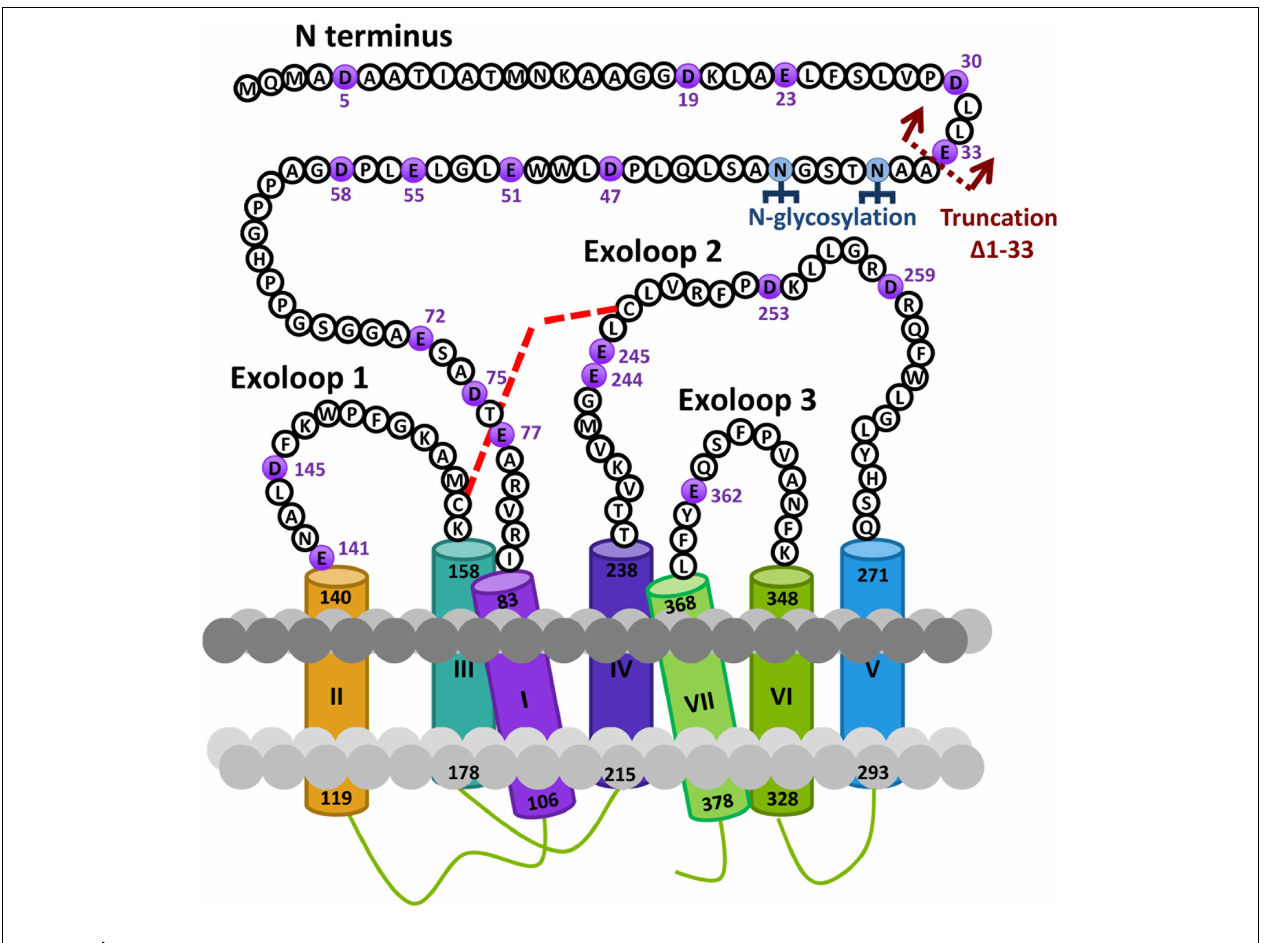
FIGURE 2 | Snake diagram of the extracellular domains of the human RXFP3 receptor highlighting residues from the N-terminus and extracellular loops (ELs). The glutamic (E) and aspartic acid (D) residues in these domains that have been mutated to alanine in this study are highlighted